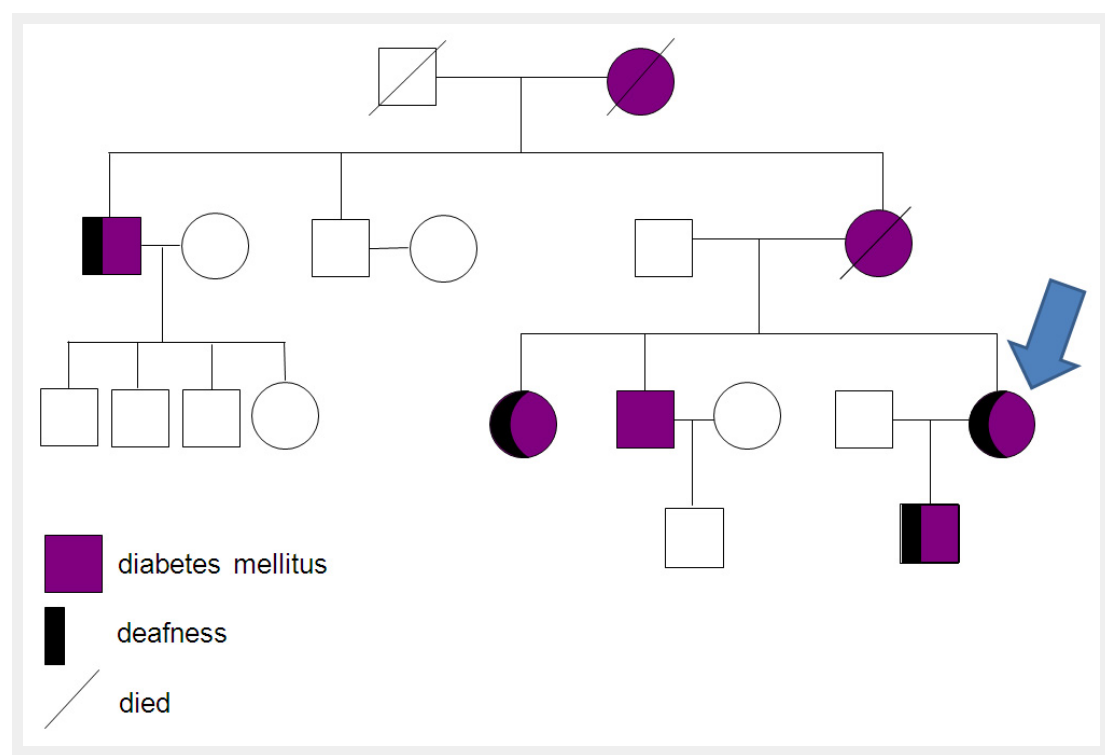
Figure 4 Pedigree of a 52-year-old woman with MIDDM (arrow), in whom diabetes was diagnosed at the age of 31 years during her first pregnancy with characteristic matrilinear transmission and hearing loss. In her son mitochondrial diabetes mellitus was diagnosed at the age of